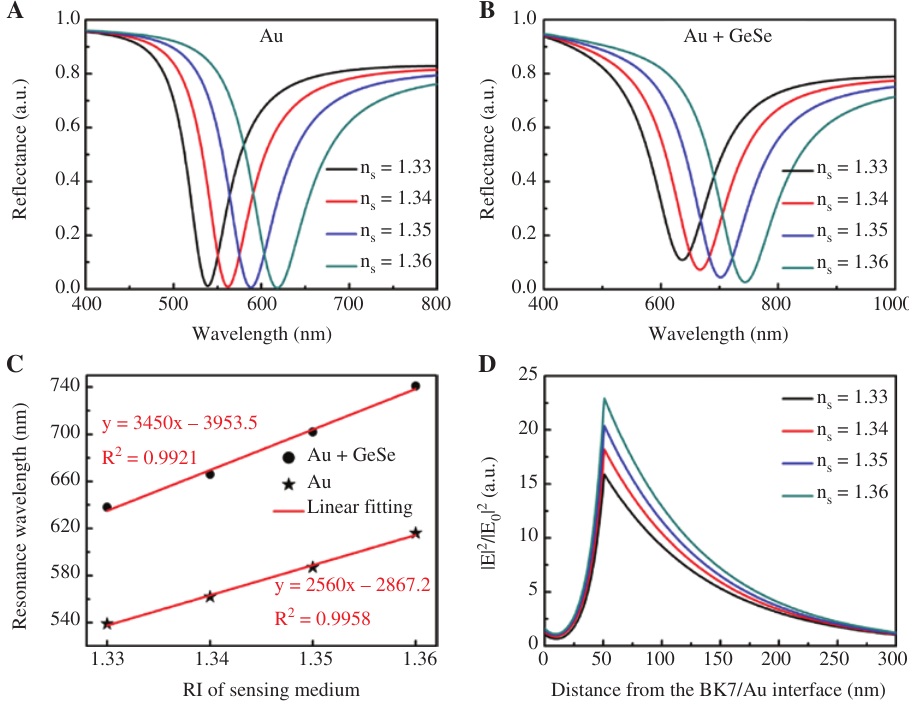
Figure 2: The numerical simulation results of the structure. Numerical simulation of reflectance with respect to the wavelength for (A) the conventional condition with only single Au film and (B) the proposed structure with additional GeSe monolayer film. (C) Fitting curve for the resonance wavelength with respect to the refractive index of sensing medium, which show the sensitivity with 2560 nm/RIU for single Au film and 3450 nm/RIU for Au + GeSe structure. (D) The electric field distributions of the proposed structure with Au + GeSe film.